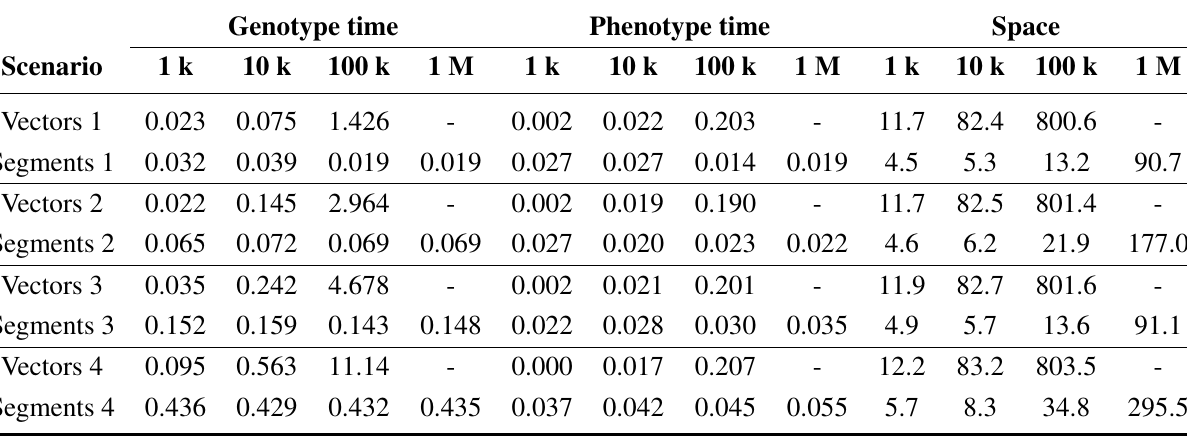
Table 2. Comparison of time (in seconds) and space (in MB) required for genotype and phenotype computation in experimental scenarios 1–4 by vector and segment representation, for one thousand to one million markers. A greater than ten-fold decrease by segments is shown in blue, while green denotes entries where vector representation ran out of